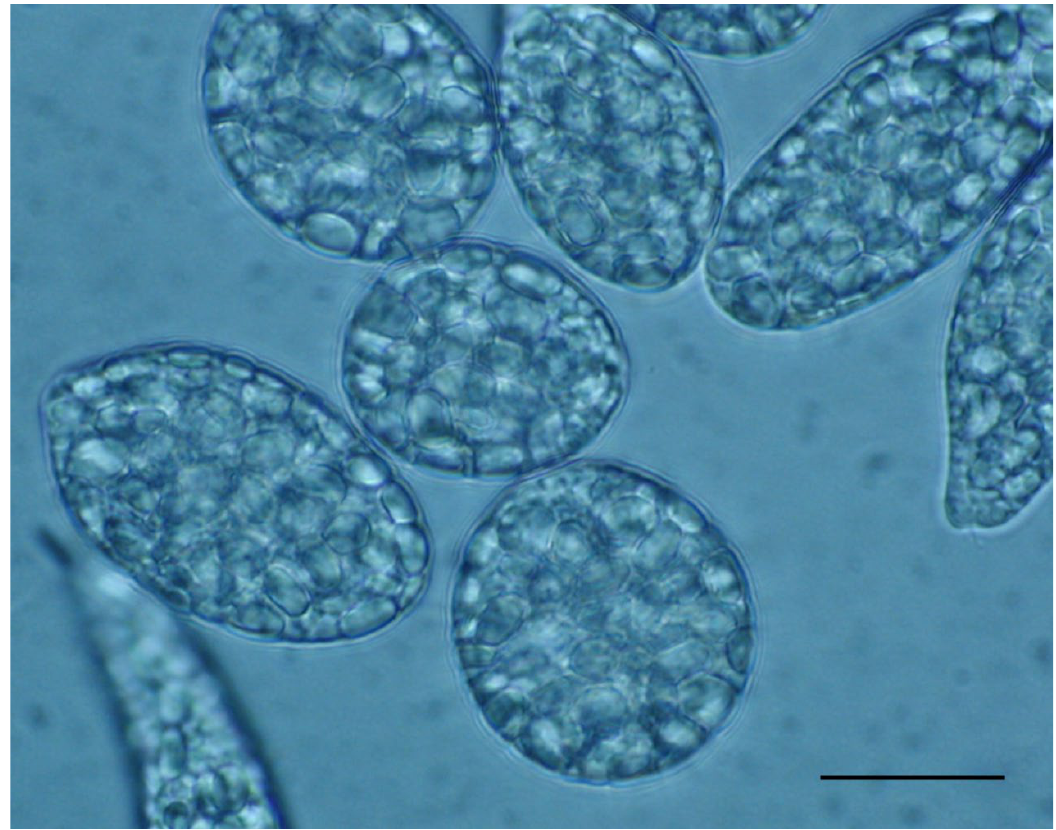
Figure 1. Cells of Euglena gracilis WZSL mutant: the very big paramylon granules fill up the cytoplasm. Scale bar: 30 μm.